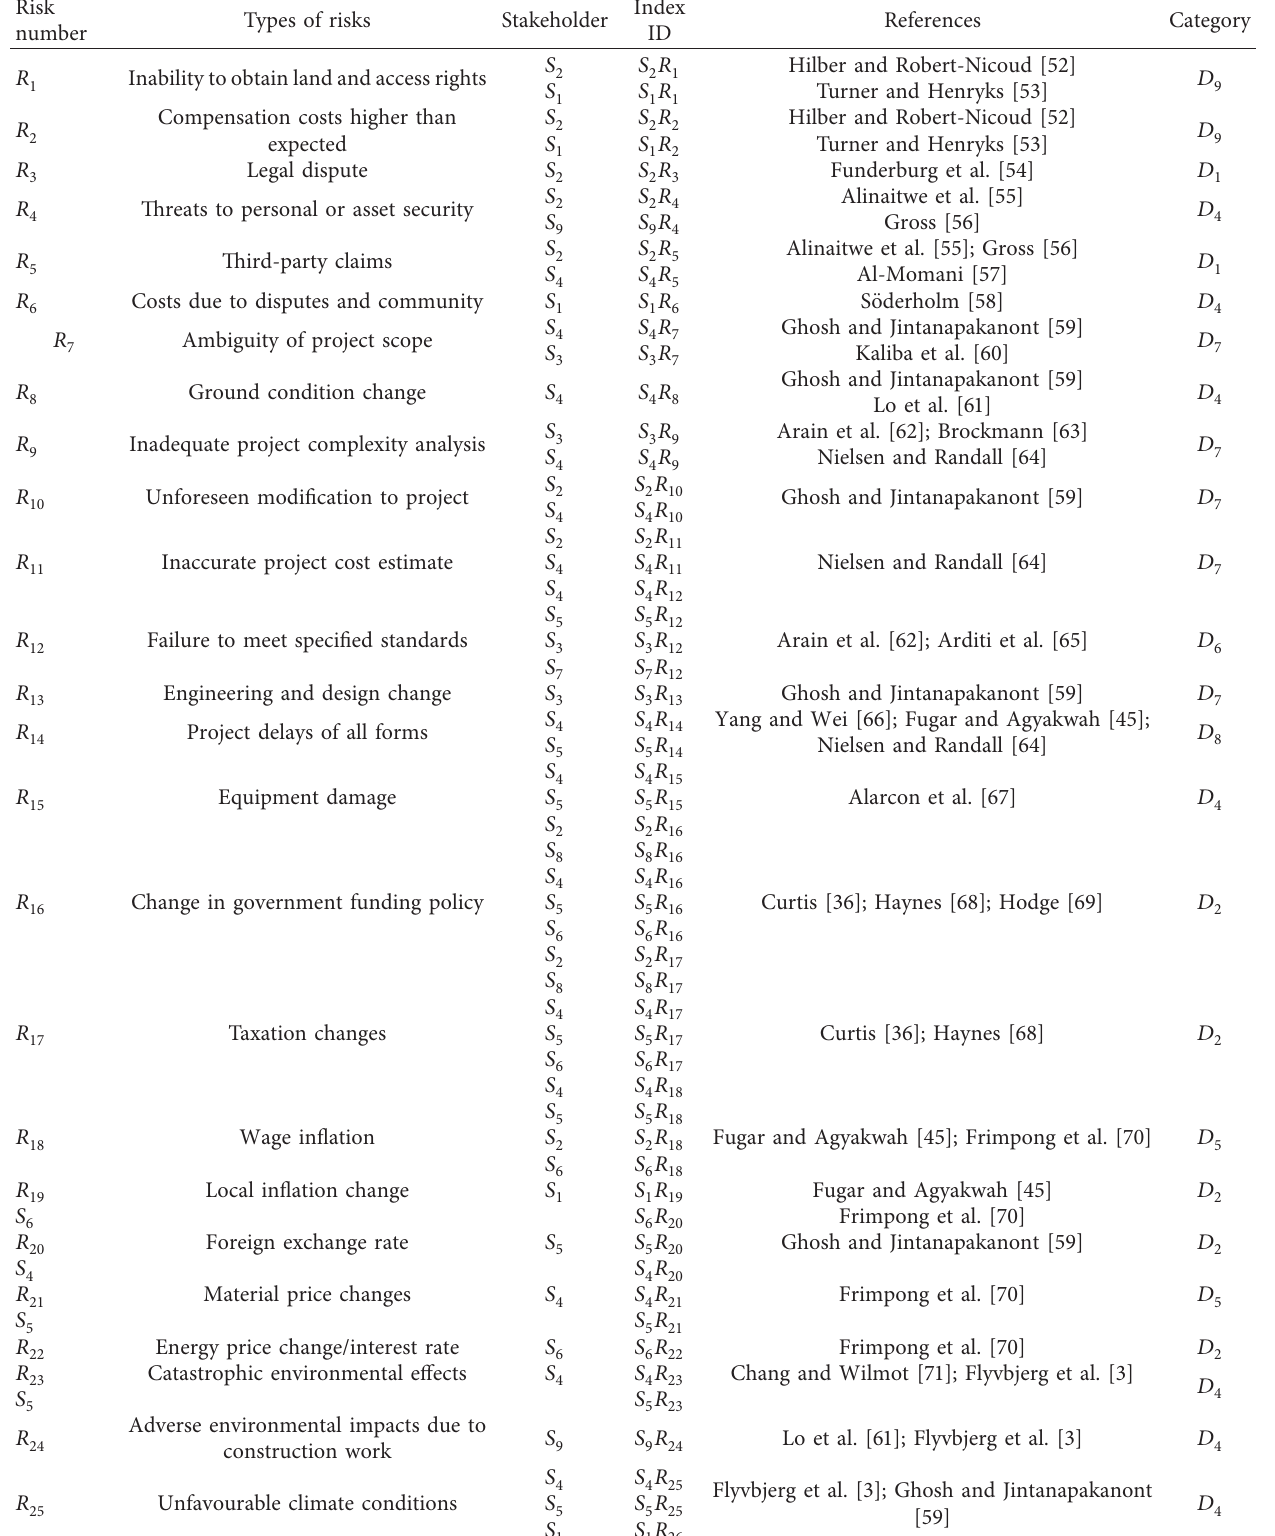
Table 3: Cost-related risks and their linked